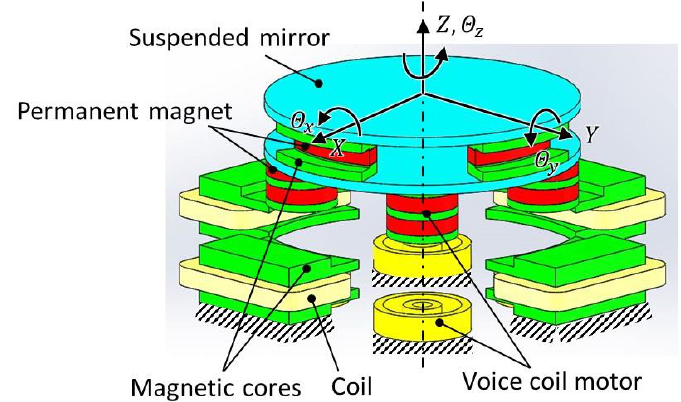
Figure 3. Configuration of an FSM in which the mirror is supported by a two-DOF controlled magnetic suspension and driven by voice coil motors (VCMs).